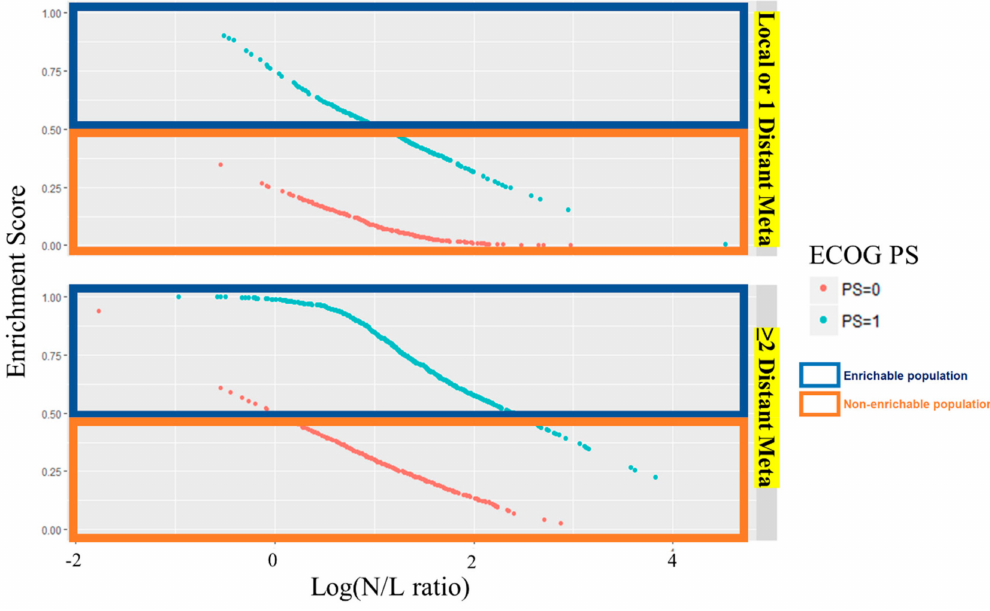
Figure 1. ECOG PS, eastern cooperative oncology group performance status; N / L, neutrophil / lymphocyte; Meta,